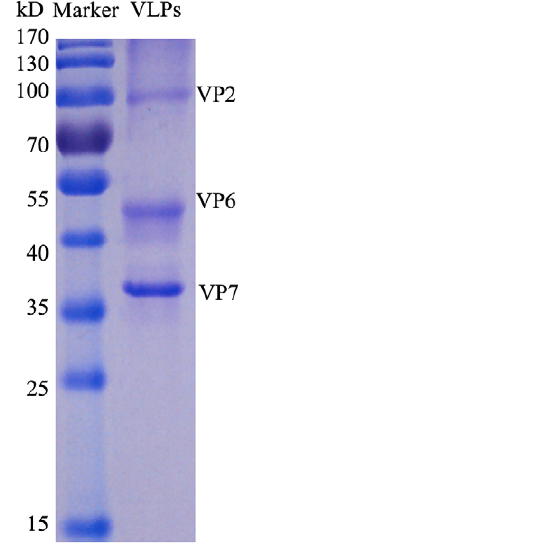
Figure 3. SDS-PAGE analysis of purified VLPs of rotavirus from silkworm. 5 m g VLPs was loaded on 12% SDS-PAGE gel. Lane Marker: standard protein marker. lane VLPs: purified VLPs from silkworm hemolymph. The three bands VP2, VP6 and VP7 were labelled.